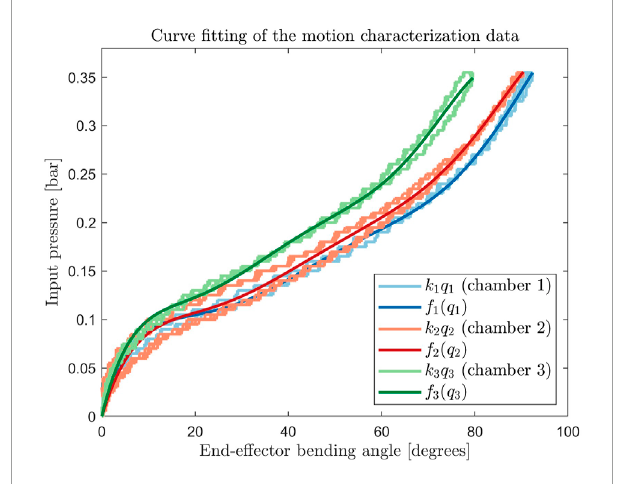
FIGURE 8 Sixth order polynomial fit of all single chamber activation motion characterization curves.